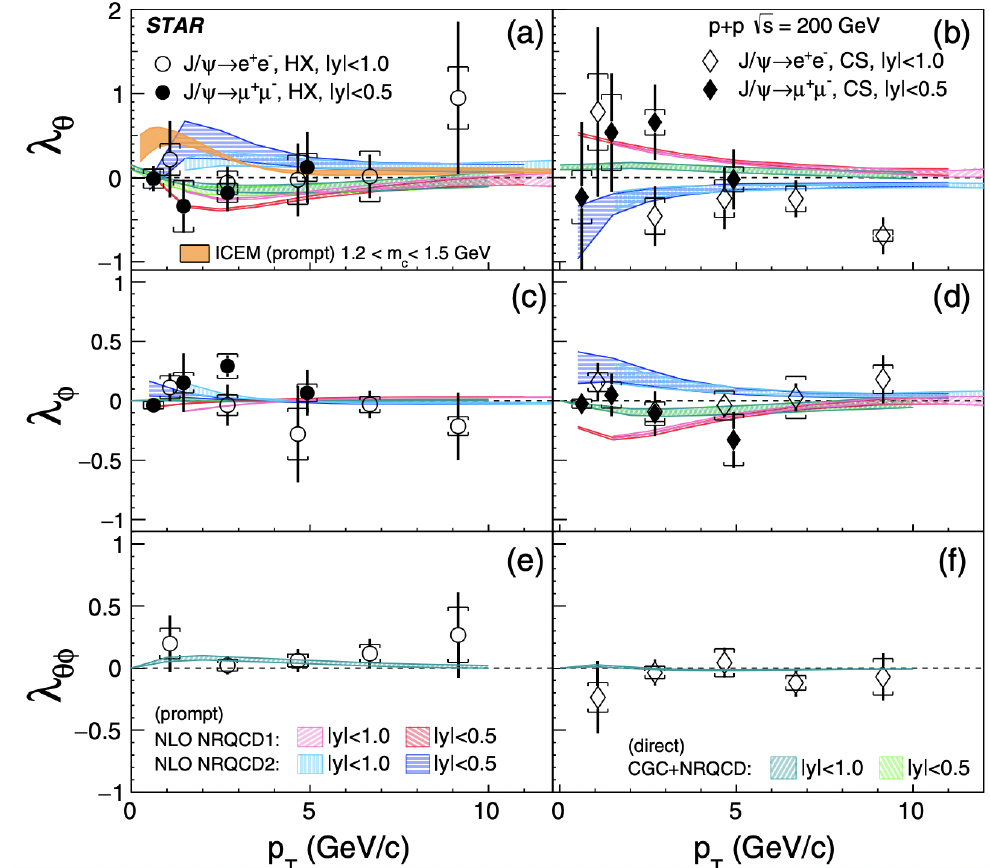
Figure 9. J / ψ polarization parameters λ θ , λ φ , and λ θφ measured in p + p collisions at mid-rapidity in the Helicity (HX) ( a , c , e ) and Collins-Soper (CS) ( b , d , f ) reference frames as a function of transverse momentum [54]. The data are compared with different theoretical models described in the text. Reprinted with permission from American Physical